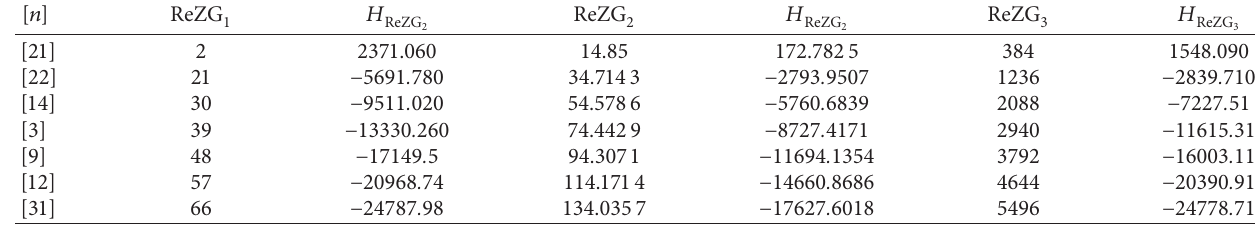
Table 9: Comparison of the redefined Zagreb rntropies with their respective heat of formations for GST − SL [ n ] . [ n ]